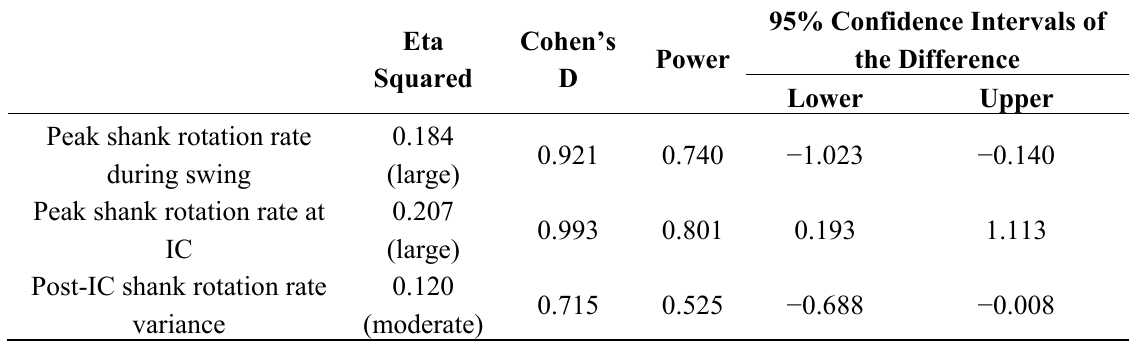
Table 3. Eta squared, cohen’s D and 95% confidence intervals of the difference for all gyroscope extracted features with significance values less than 0.05.